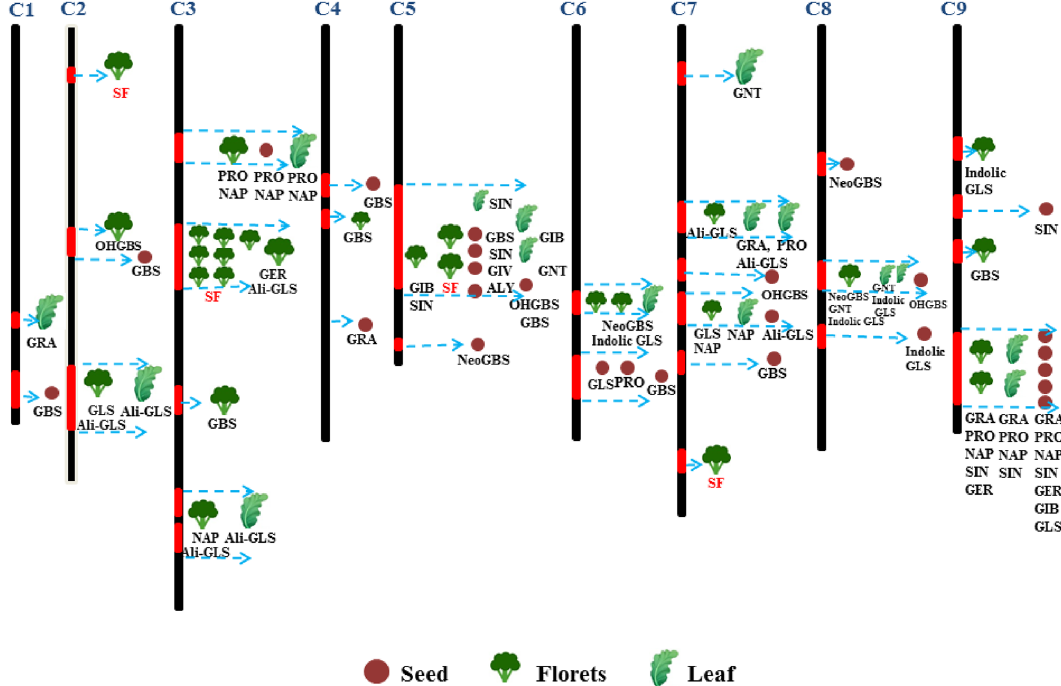
Figure 4. Framework map of broccoli populations showing the metabolic QTLs for SF, total GLS, and individual GLSs, including aliphatic GLS (Ali-GLS): glucoraphanin (GRA), gluconapin (NAP), glucobrassicanapin (GBN), glucoerucin (GER), progoitrin (PRO), sinigrin (SIN), glucoiberverin (GIV), glucoiberin (GIB), and glucoalyssin (ALY); indolic GLS (indolic GLS): glucobrassicin (GBS), neoglucobrassicin (neoGBS), and 4 hydroxyglucobrassicin (OHGBS); and an aromatic GLS (Aro-GLS): gluconasturtiin (GST). The chromosome bars were mapped based on the B. oleracea genome, previous reports and our research 30,31,49 . QTLs are represented by different shapes and colors depending on different plant organs: seeds (auburn), florets (dark green), and leaves (green). The numbers and regions of their coverage in the seeds, florets and leaf indicate the genetic loci and alleles. The column cabel (red) in the chromosomes shows the QTLs regeion for individual GLSs, and dotted arrow (light blue) points to the single or many traits. Different colors of QTLs for GLS and SF were used to distinguish between previous studies (in dark) and this work (in